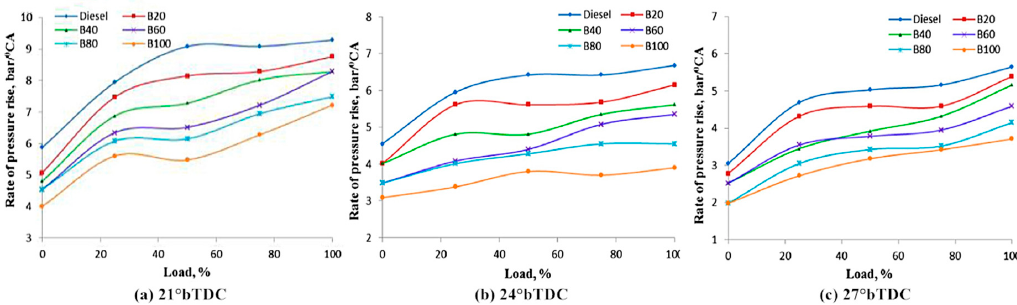
◦ bTDC. Adapted with